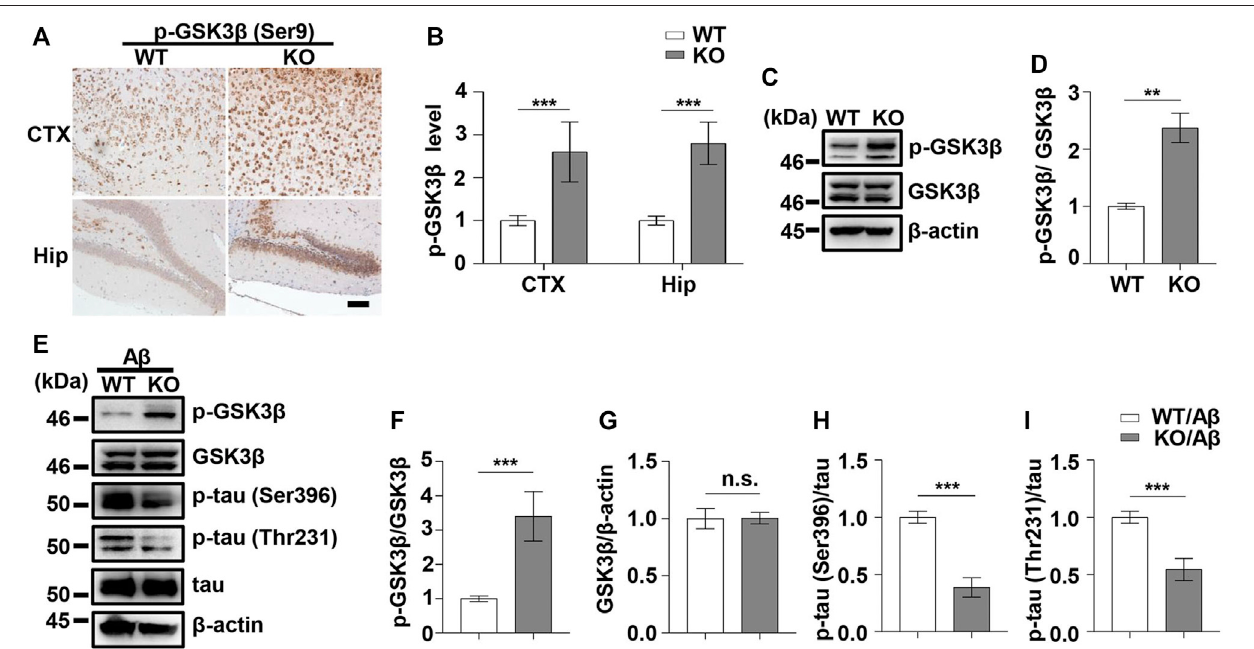
FIGURE4| PD1de fi ciencyreducedGSK3 β activityandtauhyperphosphorylationinducedbyA β 42insult.WTandPD1-de fi cientmice(C57BL/6,femaleandmale, aged2 – 3 months,n (cid:2) 8/group)wereanesthetizedandsacri fi ced,andthebraintissueswereharvestedforanalysis. (A,B) Immunohistochemistryanalysisusingtheanti- pGSK3 β (Ser9)antibodywasperformedwithparaf fi n-embeddedbraintissuesectionsfromWTandPD1KOmice(*** p < 0.001;paired t -test,scalebar (cid:2) 100 μ m). (C,D) Hippocampal tissue lysates were subjected to western blotting with the anti- β -actin, anti-pGSK3 β (Ser9), and anti-GSK3 β antibodies (*** p < 0.001, ** p < 0.01; paired t -test). WT and PD1 KO (C57BL/6, female and male, aged 2 – 3 months, n (cid:2) 8/group) mice were treated with A β 42, and after 12 days, the brain tissues were harvested. (E – I) Hippocampal tissue lysates were subjected to western blotting with the anti- β -actin, anti-pGSK3 β (Ser9), anti-GSK3 β , anti-p-tau (Thr231), anti-p-tau (Ser396), and anti-tau antibodies (*** p < 0.001). n.s., p > 0.05.